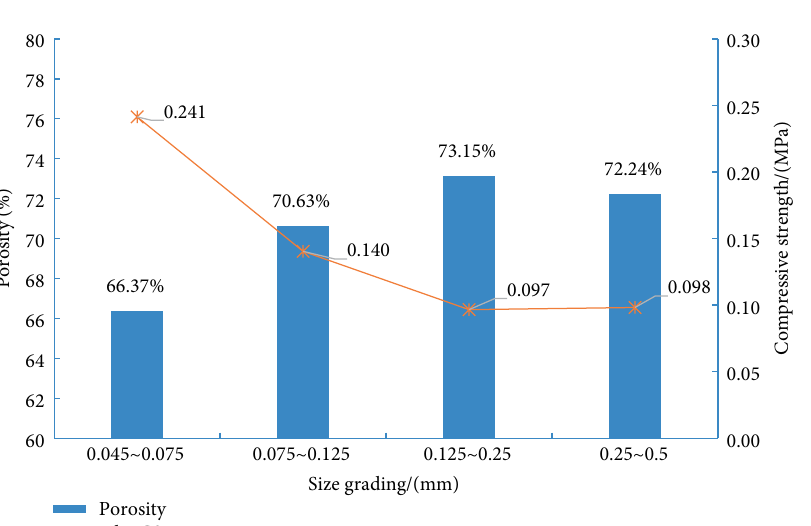
Figure 4: Pore size distribution of FAFG.